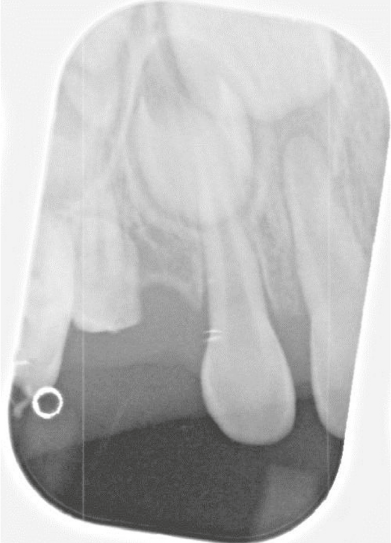
Figure 3: This radiograph demonstrates a dysmorphic maxillary right primary canine erupting ectopically into the mesial aspect of the maxillary right first primary molar. This is probably the result of incomplete extirpation by a tribal